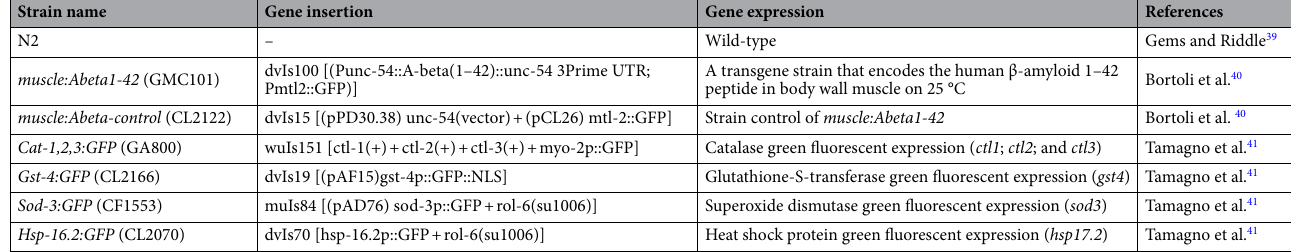
Table 1. List of strains used and insertion of the specific